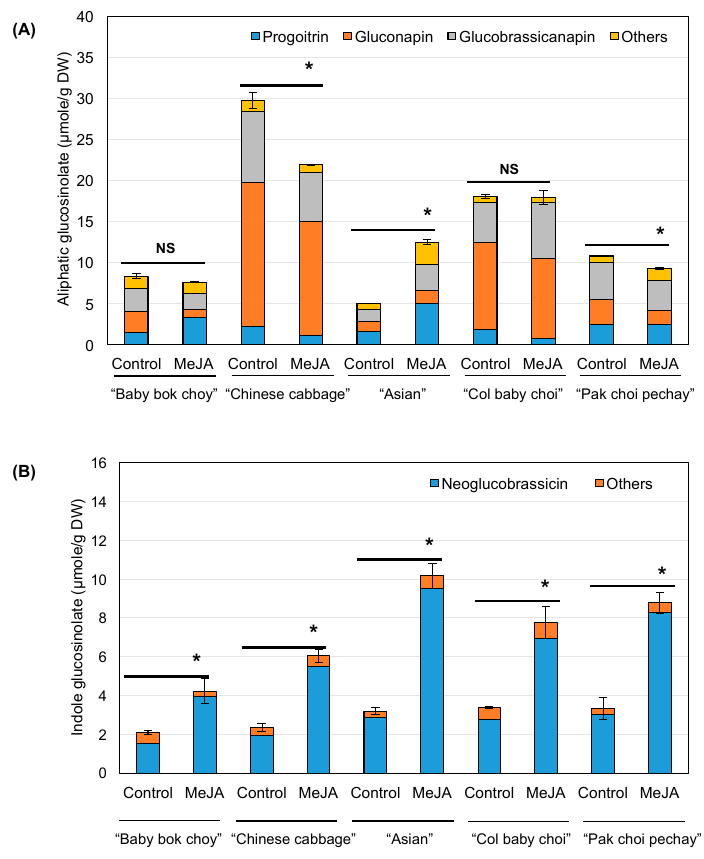
Figure 2. Aliphatic ( A ) and indole ( B ) glucosinolate concentration in control and MeJA-treated pak choi. Data are presented as the mean concentration ± the standard error of the total concentration ( n = 3). Asterisks (*) above the bar indicate a significant difference of total concentration between treatments by Student’s t -test at p ≤ 0.05. MeJA, methyl jasmonate; DW, dry weight; NS, not-significant.